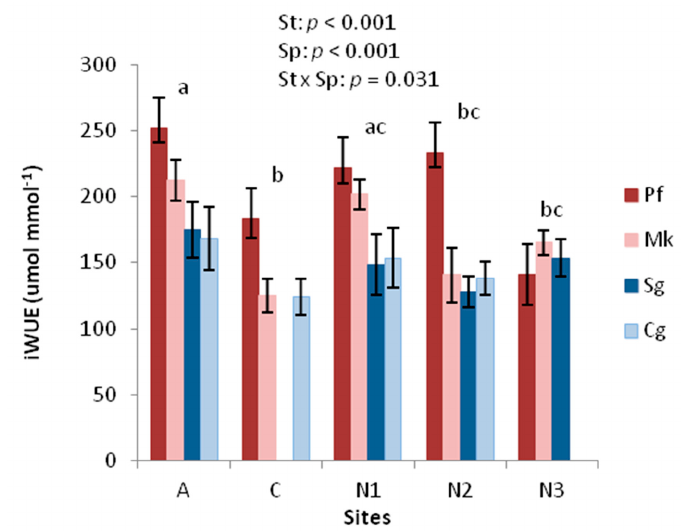
Figure 3. Intrinsic water use efficiency (iWUE = A n / g s ) from stable carbon isotope analysis of four species (Sp) at five sites (St) along an elevation gradient. Significant overall differences among sites are indicated by different letters above the bars of each site. Explanations of site abbreviations and species names are provided in Table 1 and Figure 1, respectively; the site order follows increasing elevation from left to right.